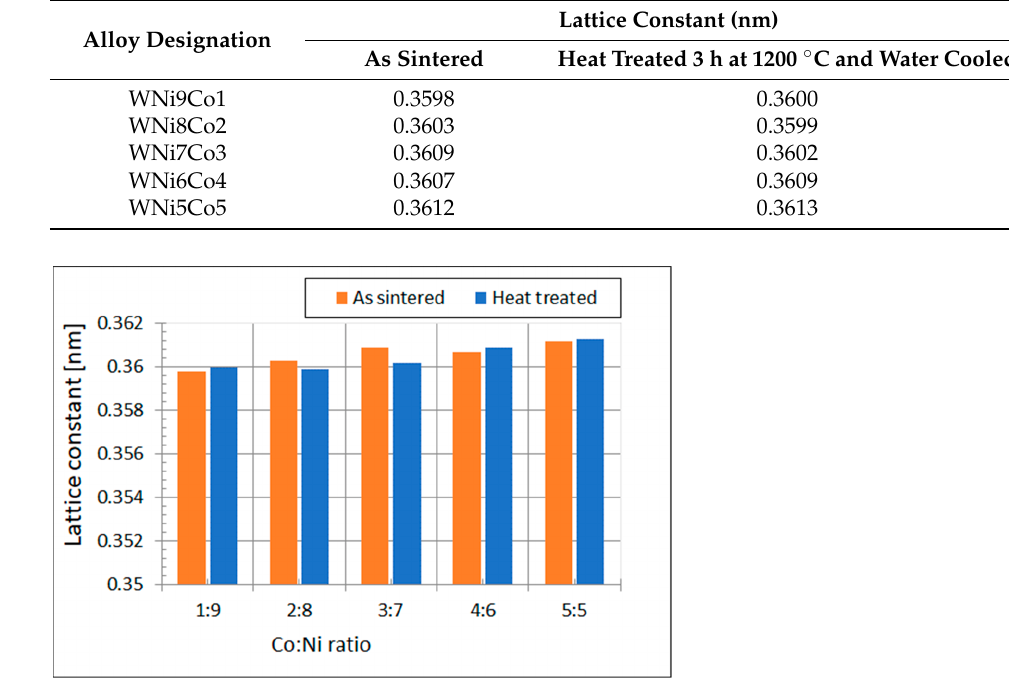
Figure 7. The changes of the Ni base matrix lattice constant.